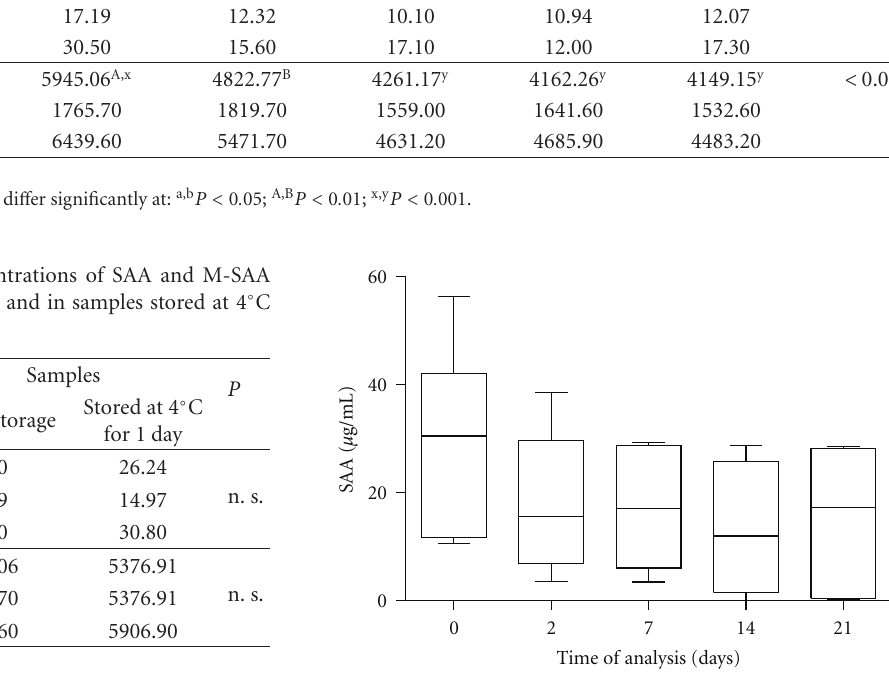
Table 1: The changes in the concentrations of SAA and M-SAA with time during freezer storage. Time of analysis (days) P Parameter